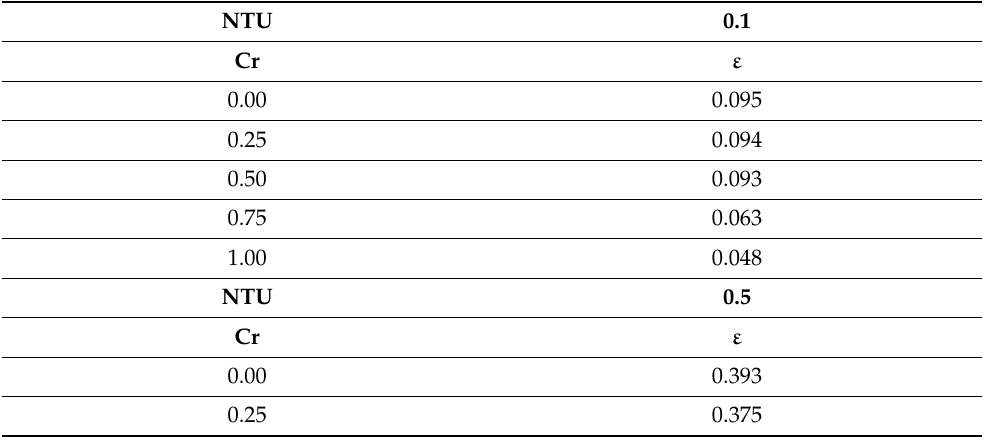
Table 3. Performance predictions of a 2-row pure cross flow heat exchanger in terms of dimensionless parameters. C min —External Fluid C max —Internal Fluid; sensible heat